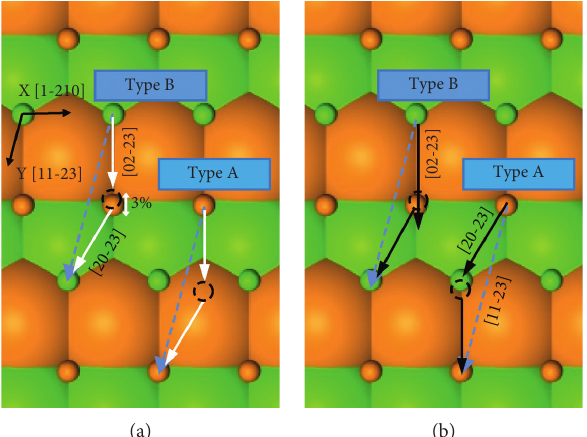
Figure 2: (a, b) The equivalent (corrugated) dissociation modes of 1011 􏼈 􏼉 1123 slip system. Orange and green spheres indicate type A and B atoms, respectively. Blue dashed line and white (black) solid line denote the full 〈 c + a 〉 dislocation and the partial dislocations, re- spectively; black dash circle denotes the stable stacking fault position of type A and B atoms. (a) Equivalent dissociation. (b) Corrugated